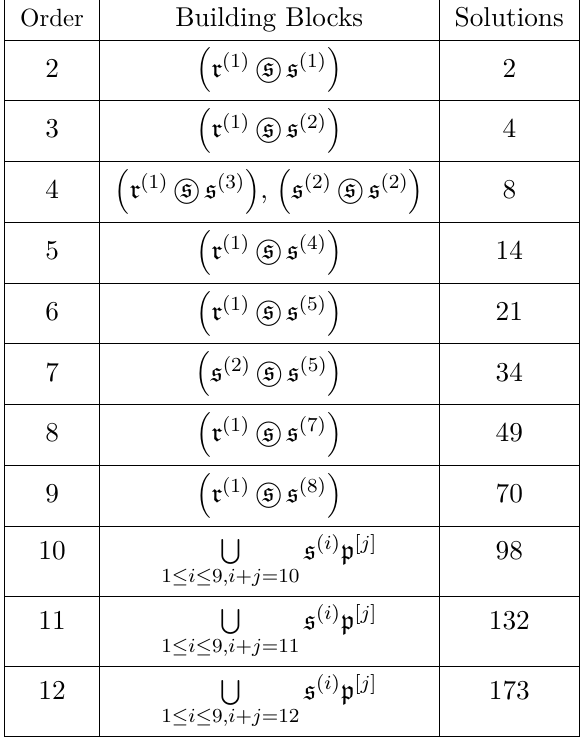
Table 4 . Total number of linearly-independent sandwich numerator scalar solutions at each order in momentum